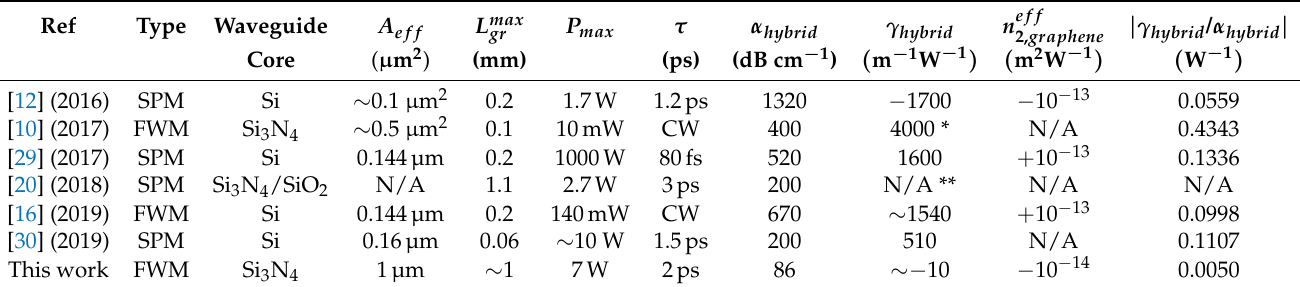
Table 2. Table of different references reporting nonlinear experiments in hybrid graphene/ dielectric waveguides at telecom wavelength. For the nonlinear coefficient along the hybrid waveguide, γ hybrid , the symbol * indicates a case in which the sign was not extracted. For the reference [20], the symbol ** is used to highlight that the nonlinearity of graphene is modelled considering carrier refraction. The comparison with γ hybrid is therefore not